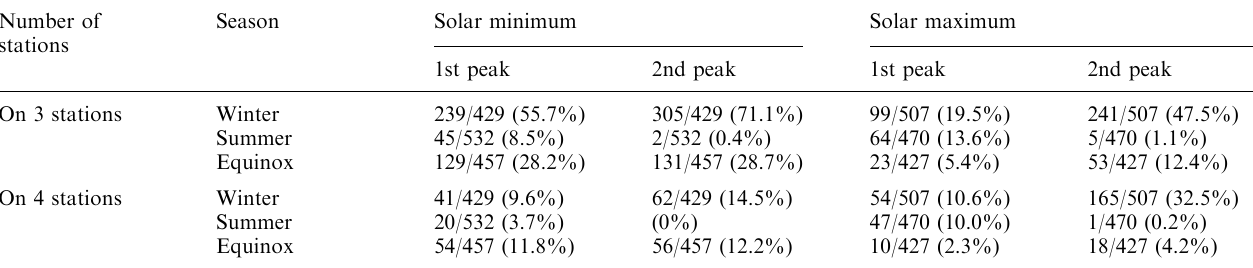
Table 5. Total number of cases (upper) of all quiet days (bottom) with the peaks simultaneously observed at 3 and 4 stations Number of